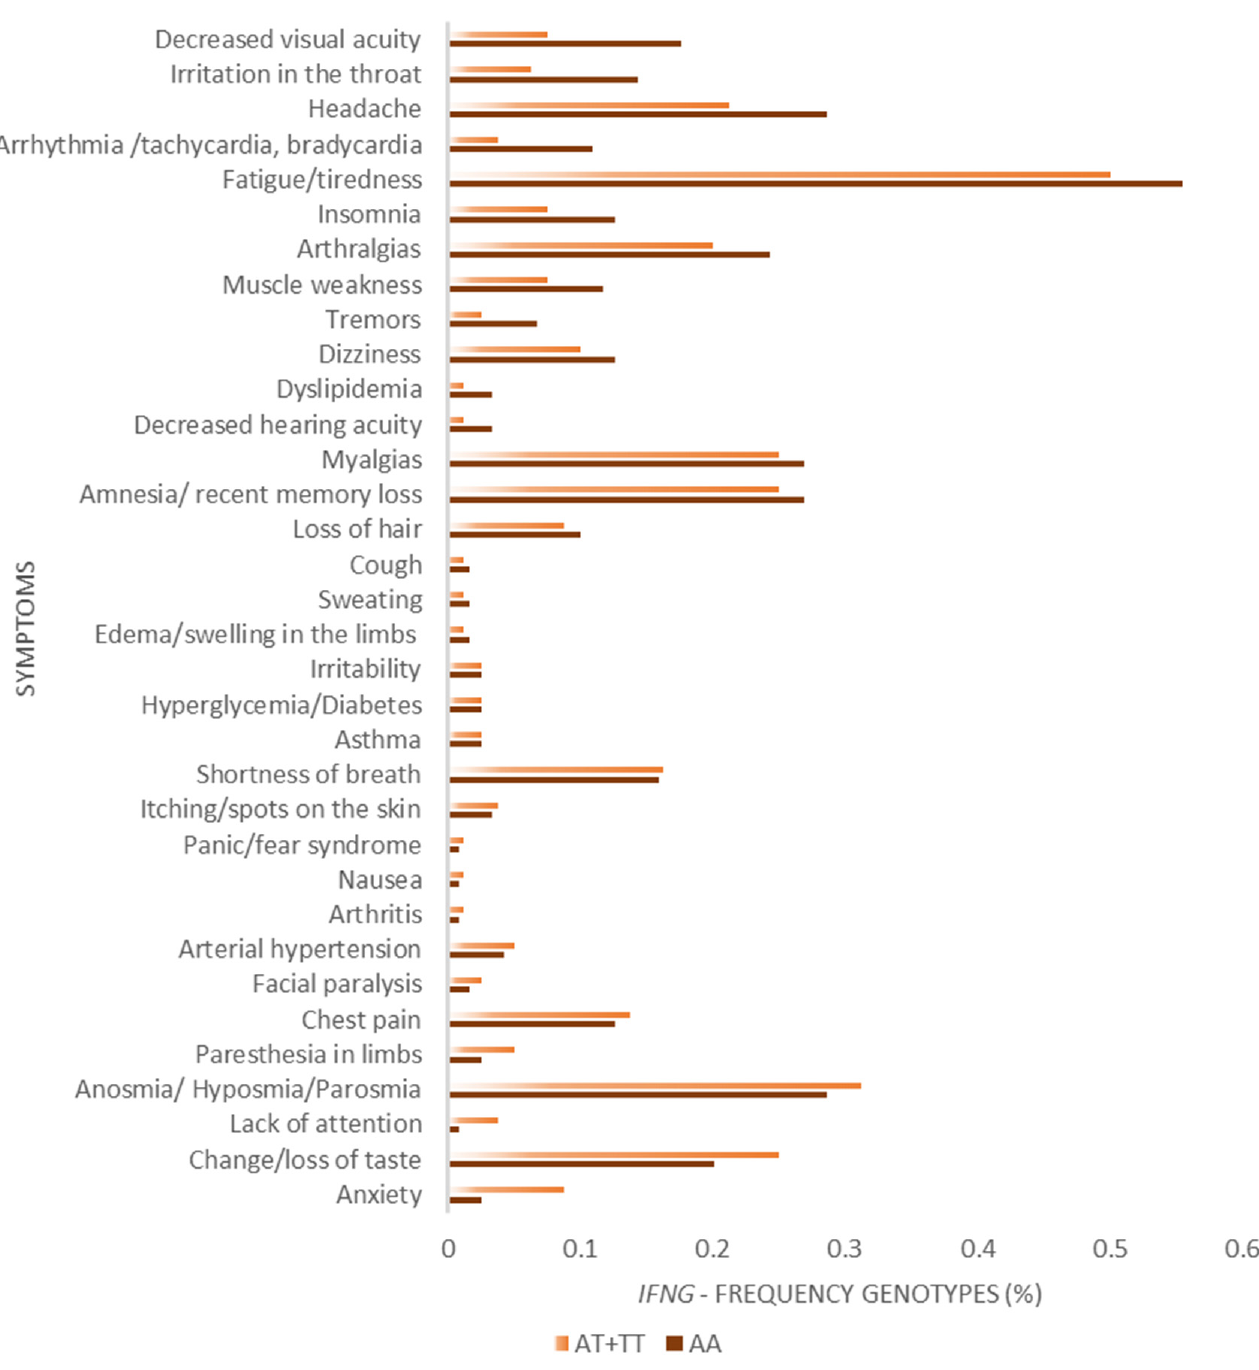
Figure 2. Comparison of frequencies of the main symptoms (%) during long COVID among IFNG AA and AT+TT genotype carriers (Paired Wilcoxon test; Z = 5.08; p < 0.0001).